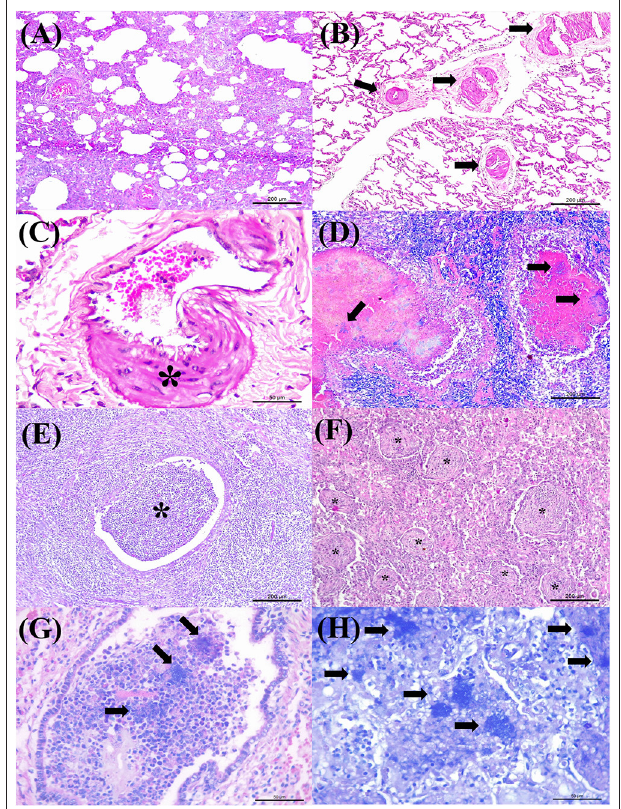
FIGURE 1 | Histopathological findings observed in the lungs of cattle with bovine respiratory disease associated with intralesional antigens of MCFV (A–C) and M. bovis (D–H) . (A) There is interstitial pneumonia, (B) containing areas of arterial proliferation (arrows); (C) higher magnification demonstrating proliferation of the tunica media of pulmonary arteries (asterisk). (D) Typical demonstration of caseonecrotic bronchopneumonia associated with infection by M. bovis ; observe the well-demarcated, centrally located, foci of necrosis containing a large necrotic hyper-eosinophilic debris and pleomorphic bacteria (arrows). (E) There is a neutrophilic exudate within a terminal bronchiole (asterisk) in a cow with suppurative bronchopneumonia. (F) Observe areas of obliterative bronchiolitis (asterisk). (G) There are intralesional bacterial aggregates positive for M. bovis (arrows). (H) Closer view demonstrating intralesional mollicutes (arrows). Hematoxylin and eosin (A–F) and Giemsa stain (G,H) . Bar: (A,B,D–F) 200 µ m; (C,G,H) 50 µ